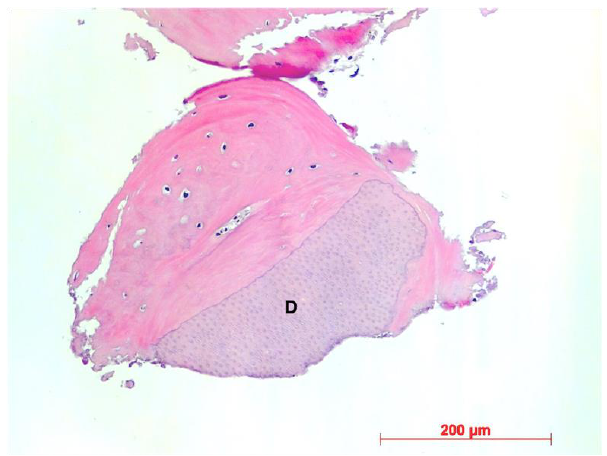
Figure 7. Patient 1—Dentin granule (D) embedded into newly formed bone, HE, original magnification × 20.